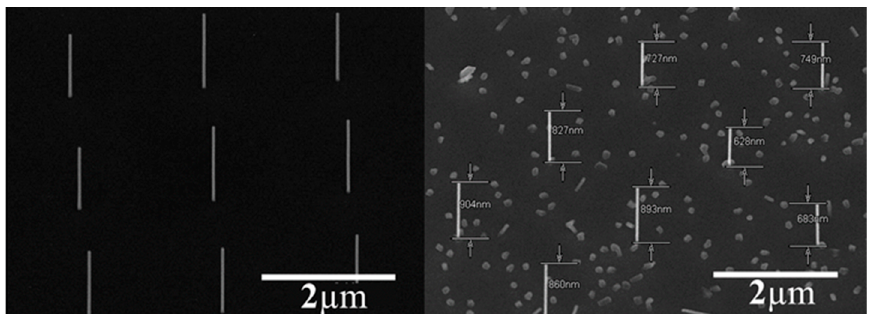
Figure 3. Homoepitaxial growth of III–V NWs. Left hand side, InP NWs on InP <111> (following [38]) and right hand side, InAs. This type of growth did not result in any bending or radial asymmetry, demonstrating that bending and asymmetry arise due to heterostructure growth.